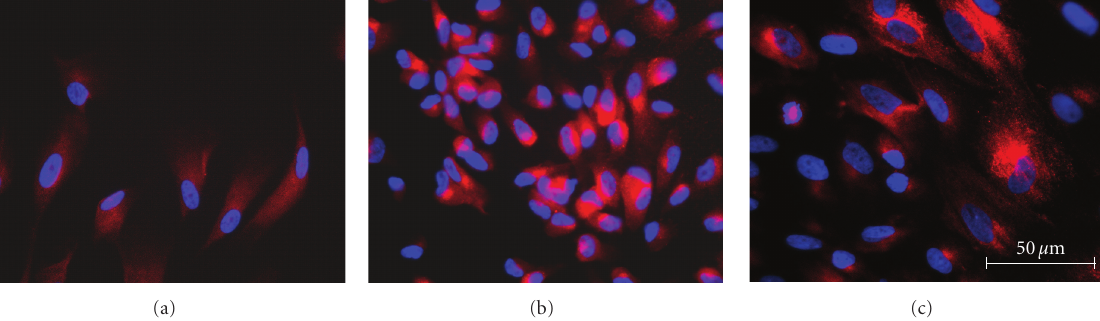
Figure 7: GDNF expression by cNPCs before and after transduction and di ff erentiation. Immunocytochemistry (ICC) was performed on cNPCs using a rabbit anti-human GDNF antibody to evaluate expression of GDNF at the protein level, before and after transduction and before and after exposure to growth factor deprived/FBS-containing di ff erentiation conditions (UM-FBS). (a) Nontransduced cNPCp20 cultured in UM (proliferation conditions) exhibit baseline cytoplasmic labeling for GDNF (red). (b) Lenti-GDNF-GFP vector transduced cNPCs cultured in UM show increased intensity of GDNF (red) labeling. (c) Transduced cNPCs cultured in UM-FBS (di ff erentiation conditions) are larger in size and show persistent overexpression of GDNF (red), that is, heterogeneously distributed among the profiles. Nuclear labeling = DAPI (blue), scale bar = 50 μ